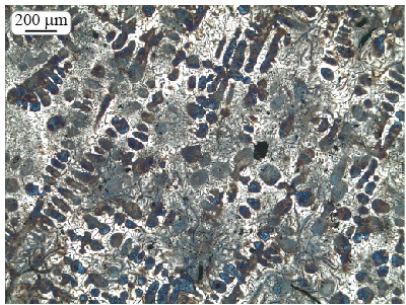
hyd D = 35 μ m and SDAS hyd = 35 µ m and D = 35 μ m and SDAS IP IP IP